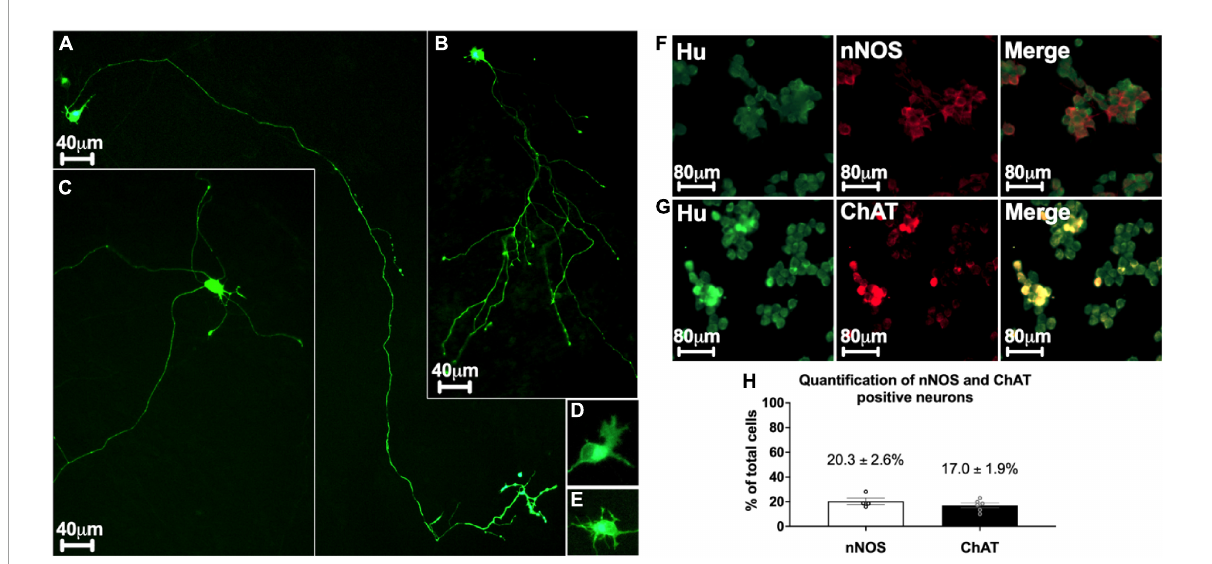
FIGURE3 Morphological and phenotypical characterization of enteric neurons. (A–E) mGFP transfected enteric neurons at D3. (A,B) Monoaxonal enteric neurons with a small-diameter cell body. Monoaxonal neurons can be sorted into two sub-types based on axon morphology: long axonal process with sparse and short ramifications (A) or medium-length axon with numerous ramifications (B) . (C) Multiaxonal neurons exhibiting more than 2 axons of medium to short length and a large-diameter cell body (183 neurons analyzed from n = 4 culture wells from 4 independent rat embryos). (D,E) Neuron with lamellar (D) and filamentous (E) dendrites (110 neurons analyzed from n = 3 culture wells from 3 independent rat embryos). (F,G) Double immunostaining of enteric neurons with the neuronal cell body marker Hu (green) with either nNOS (red, F) or ChAT (red, G) at D7. (H) Percentage of neurons immunostained with neuronal nNOS and ChAT at day 7. Data are presented as mean ± SEM from 886 neurons analyzed from n = 4 culture wells from 4 independent rat